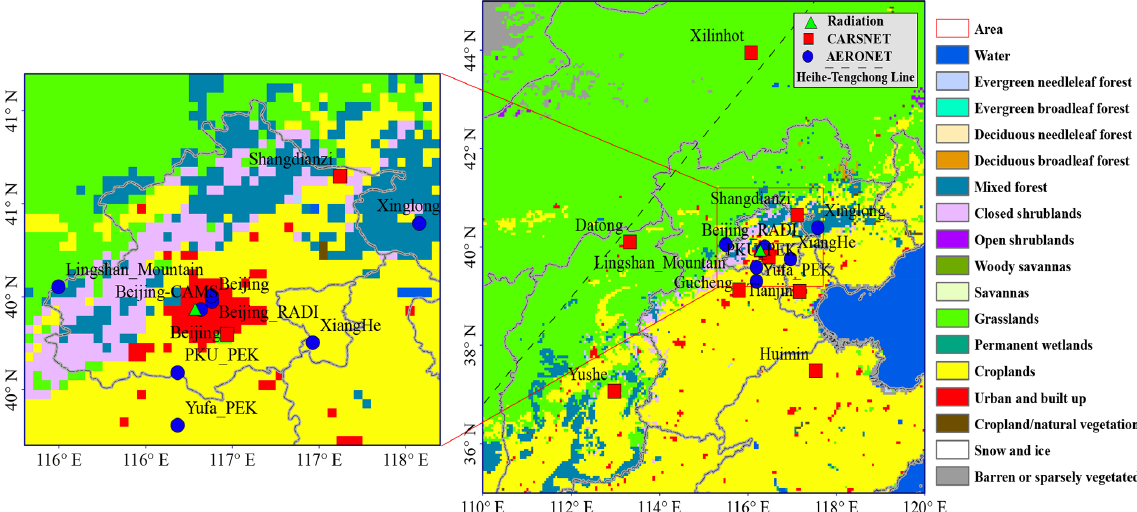
Figure 1. Study area, with the locations of the ground-based reference sites discussed in Sect. 2.3 (CARSNET: red squares; AERONET: blue circles; solar radiation station: green triangle) overlaid on the IGBP land cover